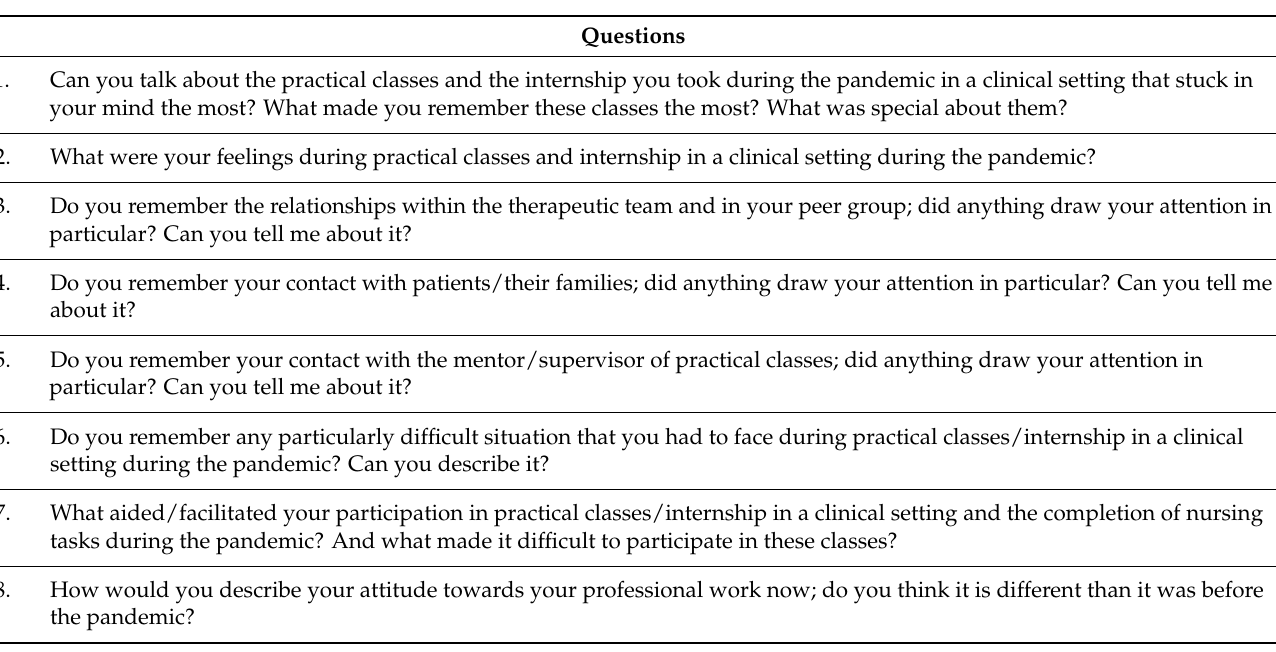
Table 2. Questions which guided the interview with